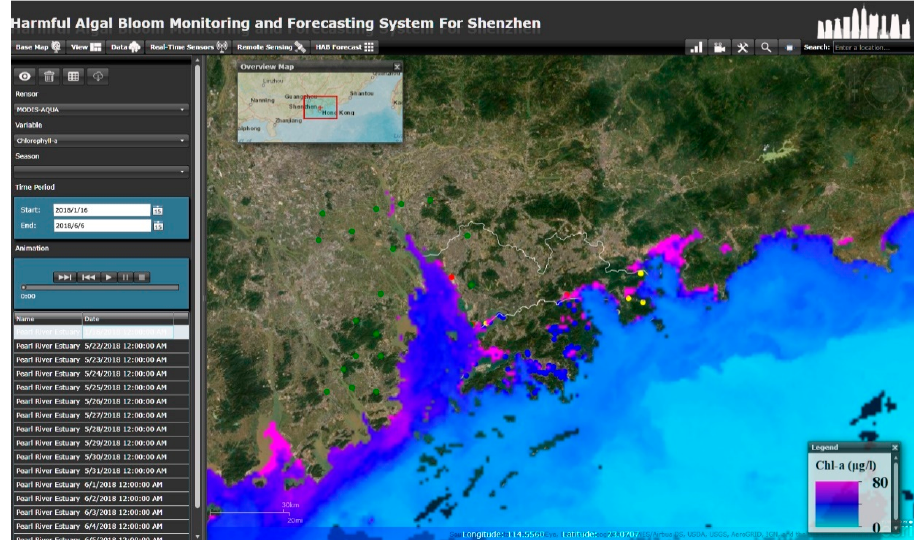
Figure 6. Visualization of chlorophyll (Chl-a) concentration from Moderate-Resolution Imaging Spectroradiometer (MODIS)-Aqua products over Shenzhen coastal areas on 16 January 2018.